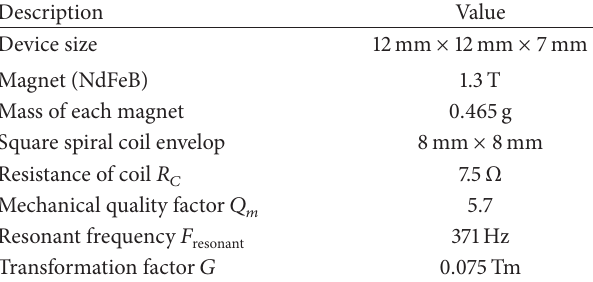
Table 2: Dimensions and parameters of the EMEH prototype [17].